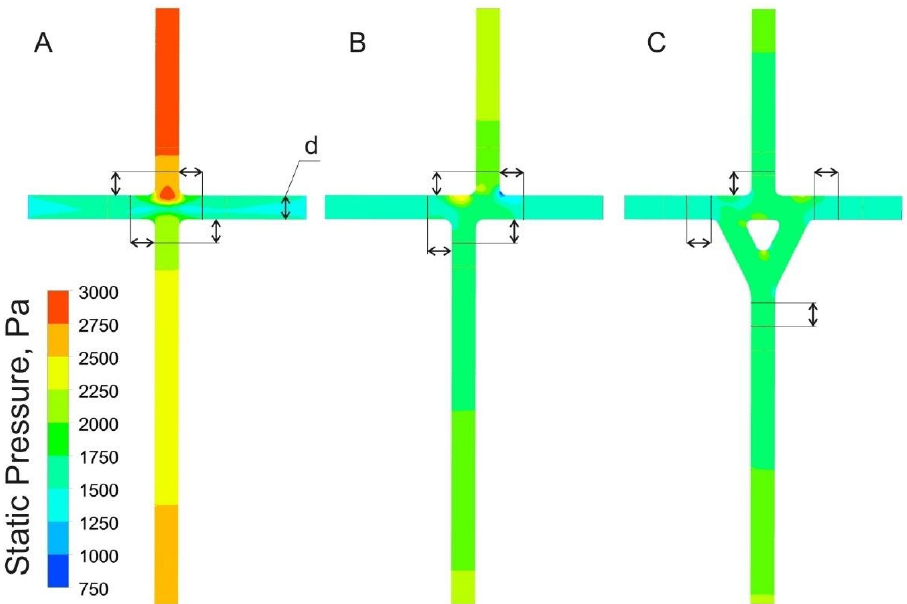
Figure 9. The contour plot of the static pressure distribution. Pressure values for the color gradient are given in the sub picture. The greatest power loss is in TCPC-1. The flow in TCPC-2 hits the wall of the pulmonary artery, as a result local pressure increases due to a decrease in the flow rate. TCPC-3 pressure distribution is steady and well-distributed.